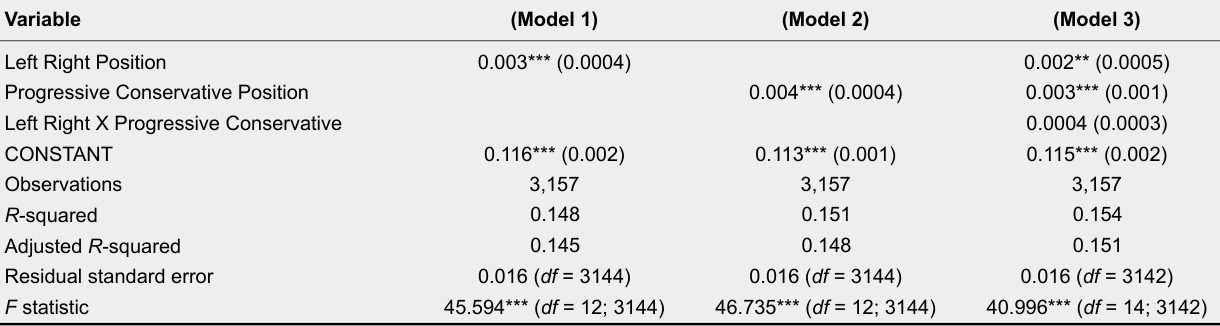
Note. Standardized coefficients, standard errors in